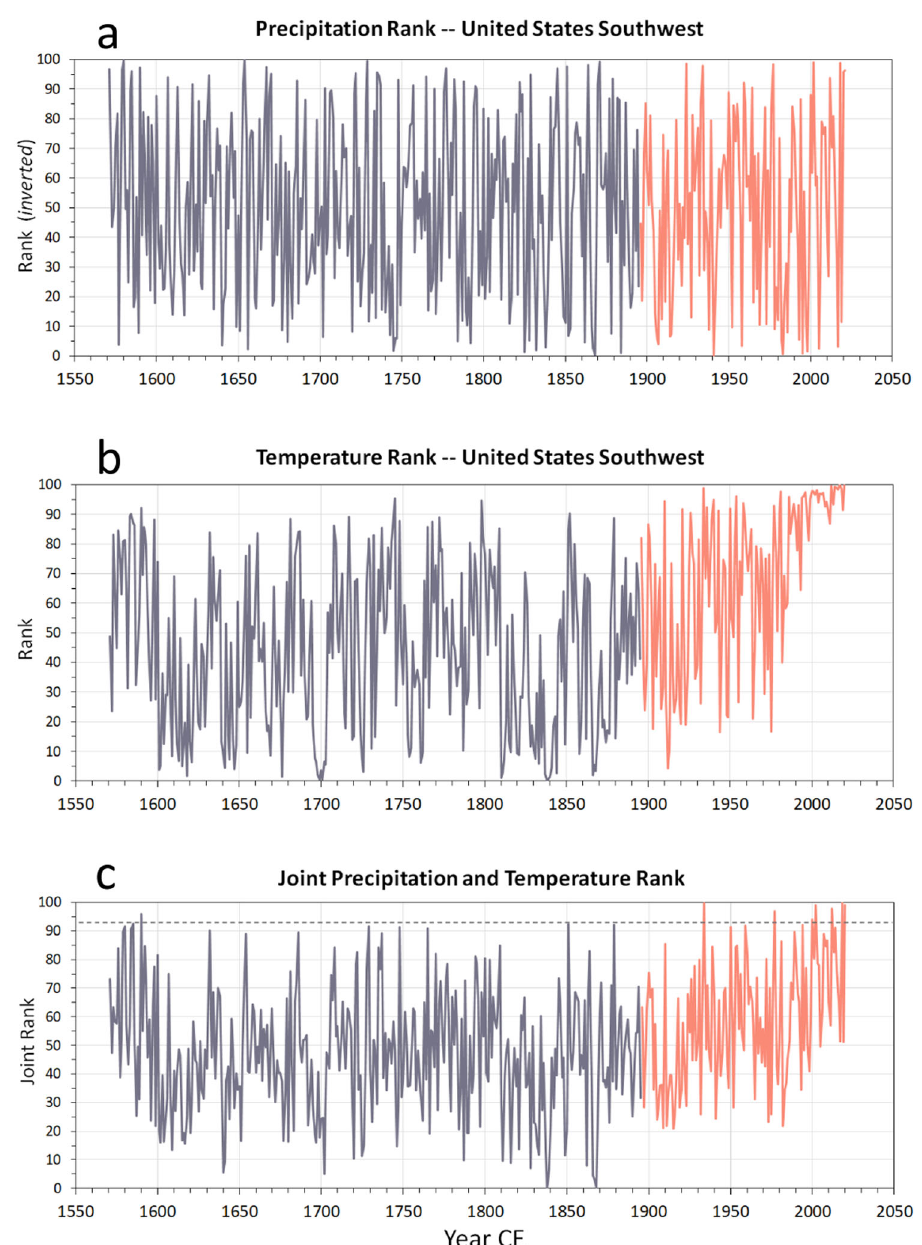
Fig. 2 Southwest historical water year precipitation and calendar year annual mean temperature rank values. Rank values (normalized between 0 and 100) for the SW precipitation ( a ) and temperature ( b ) time series shown in Fig. 1, and joint rankings ( c ); time periods are 1571 – 2021 for precipitation and 1571 – 2020 for temperature and joint ranks. Precipitation ranks are inverted so lowest rank represents highest value/highest rank represents lowest value. Color scheme follows Fig. 1. Dashed line in c indicates ten years with highest (warm/dry) joint